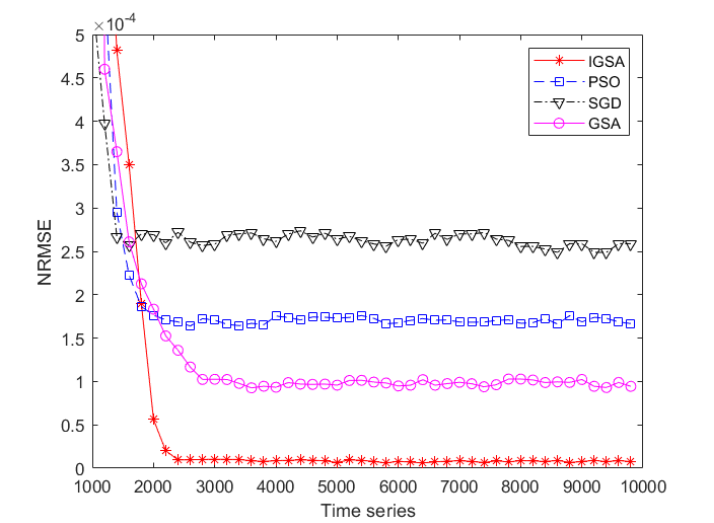
Figure 14. Training NRMSE for the MG time series.